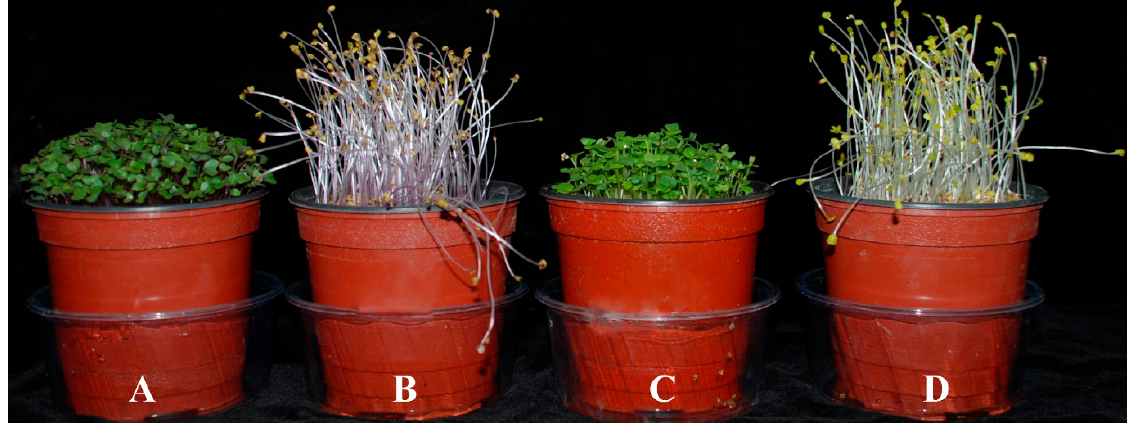
Figure 1. Kohlrabi sprout grown under light and dark conditions for 10 days. ( A ) Purple kohlrabi grown under light, ( B ) purple kohlrabi grown under dark, ( C ) pale green kohlrabi grown under light, and ( D ) pale green kohlrabi grown under dark.